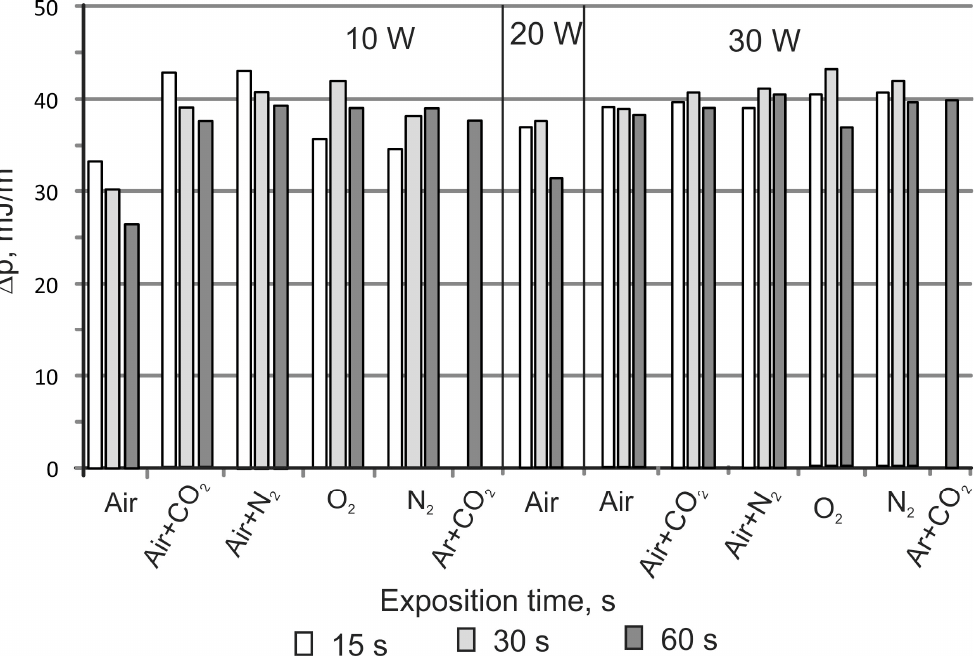
Figure 5. Effect of the gas composition, exposure time, and discharge power on the change in the polar component ∆ p .